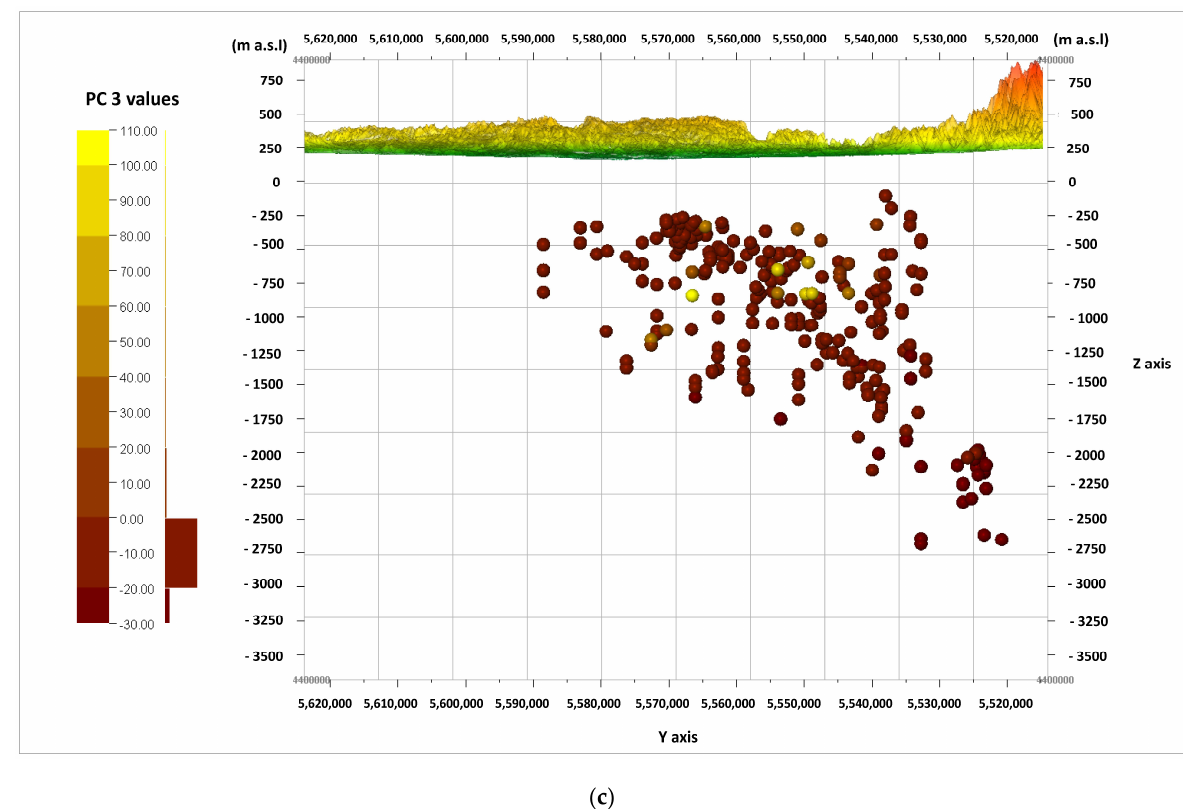
Figure 13. Cross-section in the line N–S and values of the principal components (PC) calculated for the cases, viewed from the W. principal components: ( a ) PC 1; ( b ) PC 2; ( c ) PC 3.